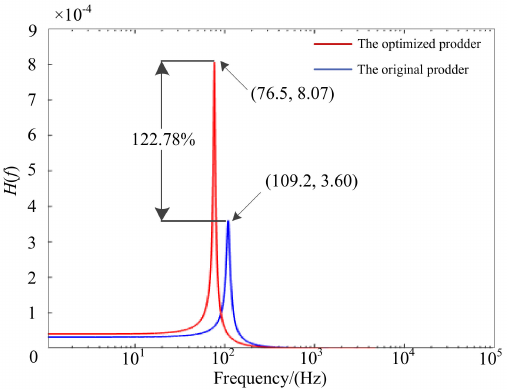
Figure 12. Performances comparison between the optimized prodder and the original prodder.